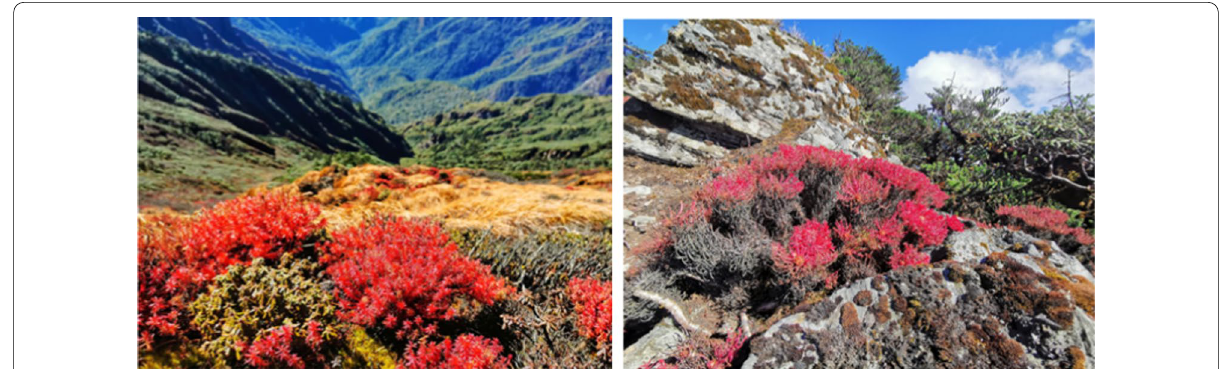
Fig. 18 Rhodiola rosea (Yunnan, China) (These photos were taken by Dr. Wang